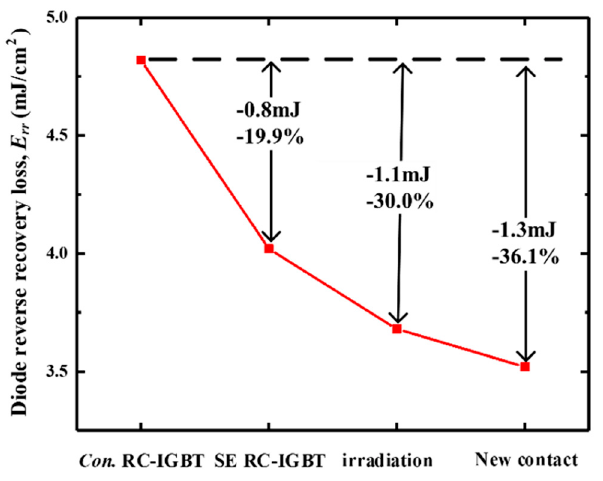
Figure 15. The built-in diode’s reverse recovery loss E rr for several